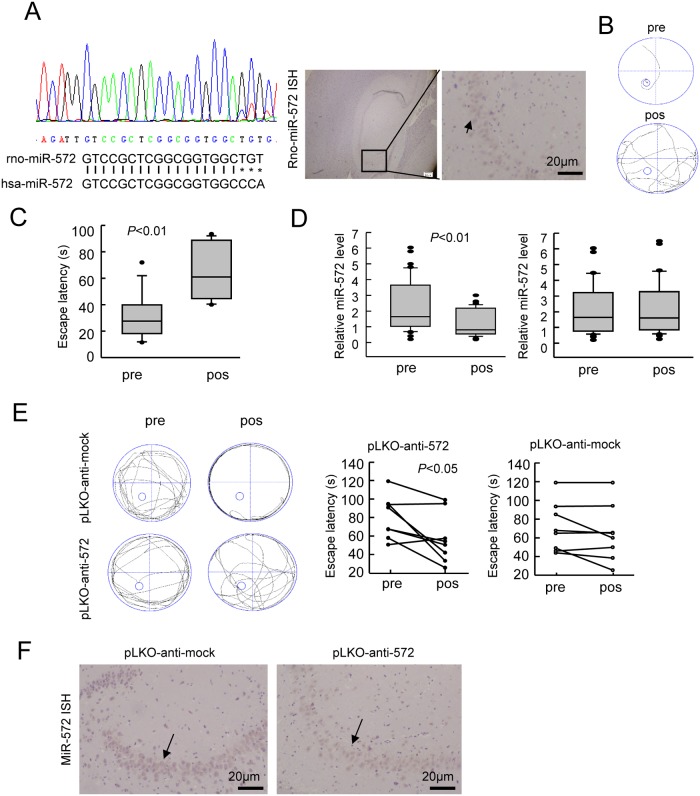
Effects of miR-572 on the cognitive function of the POCD rat model.A. Detection of miR-572 in rat peripheral blood (left) and in situ hybridization detection of miR-572 expression in the rat hippocampus area. B. Schematics of the water maze routes. C. After surgery, the POCD rats had a longer latency in finding the platform in the water maze test compared to the time needed before surgery. D. Real-time quantitative PCR detection of miR-572 in the peripheral blood of POCD rats and non-POCD rats before and after surgery. In POCD rats, the postoperative miR-572 expression in the peripheral blood was lower than the preoperative level (left), while the non-POCD rats did not show significant changes in the miR-572 expression before and after surgery (right). E. Schematic diagram of the water maze route for the POCD rats after treatment with the miR-572 inhibitor (left). After treatment, the latency of the rats in the water maze test was significantly reduced (middle), whereas the control group showed no significant improvement (right). F. In situ hybridization detection found that after injection of inhibitors, the expression level of miR-572 in the rat hippocampus was decreased. pre, preoperation; pos, postoperation.